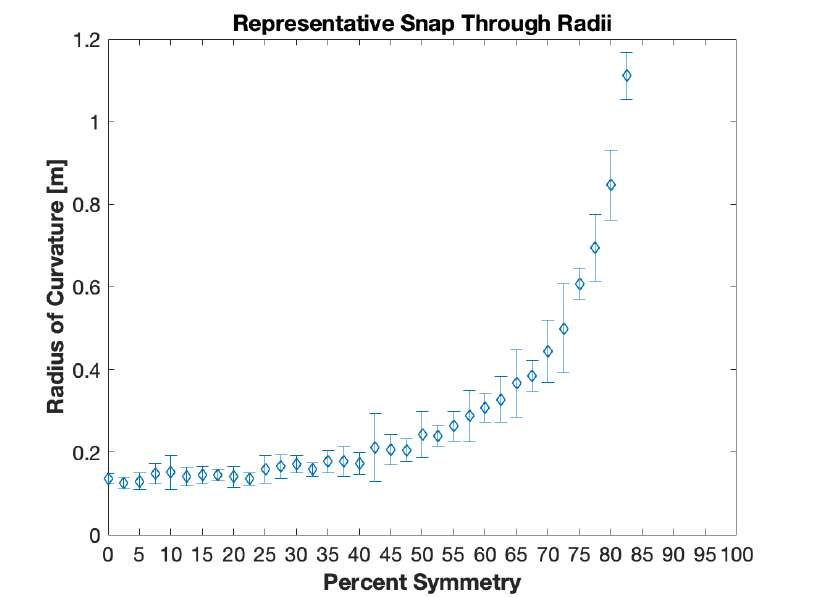
Figure 9. The snap through representative radius of curvature versus the percent